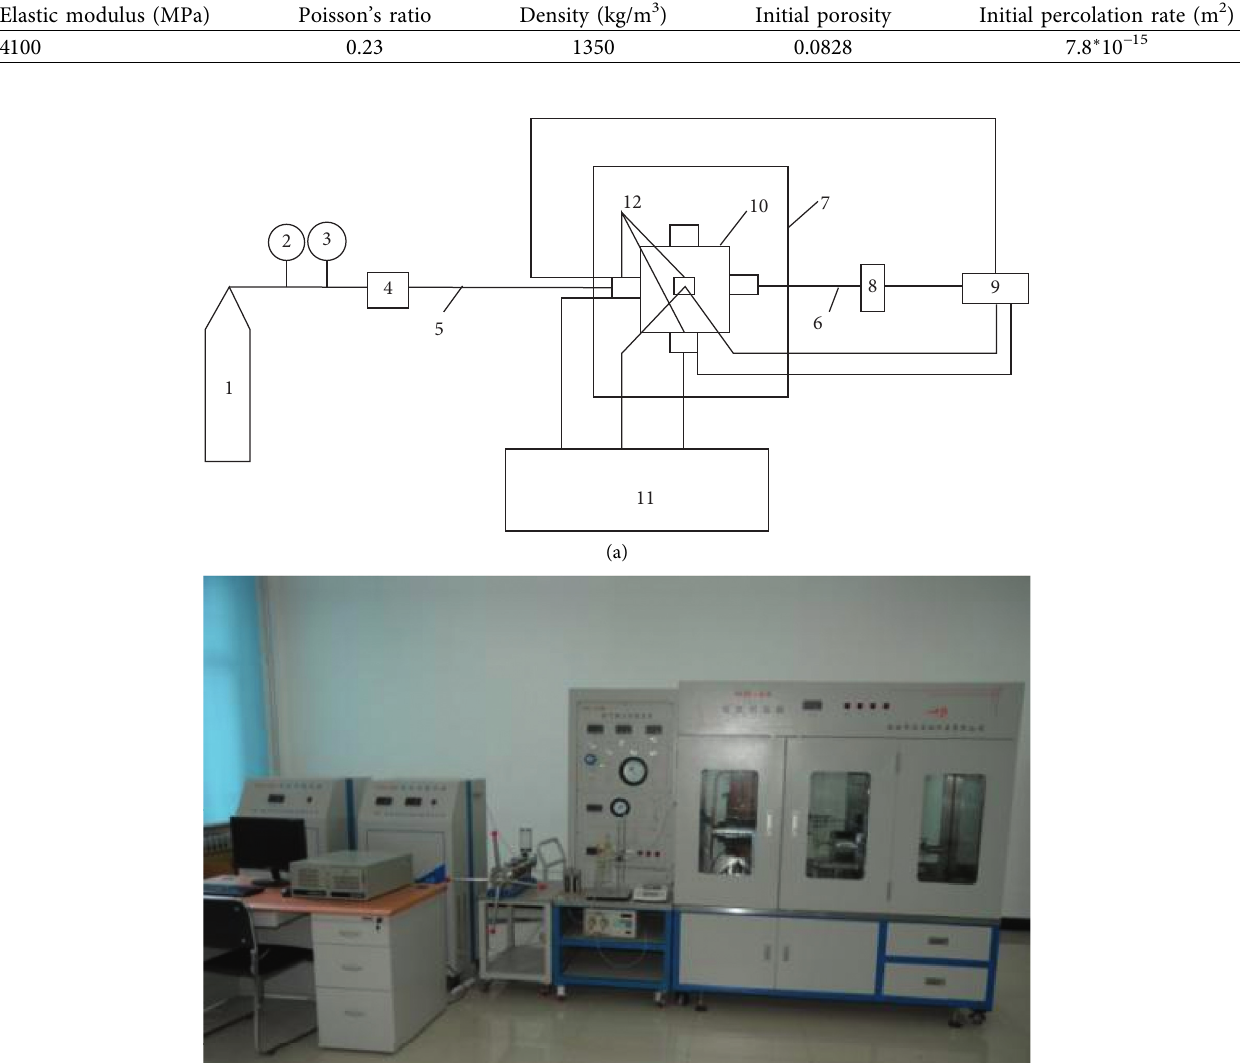
Table 1: Basic physical properties of experimental coal samples.